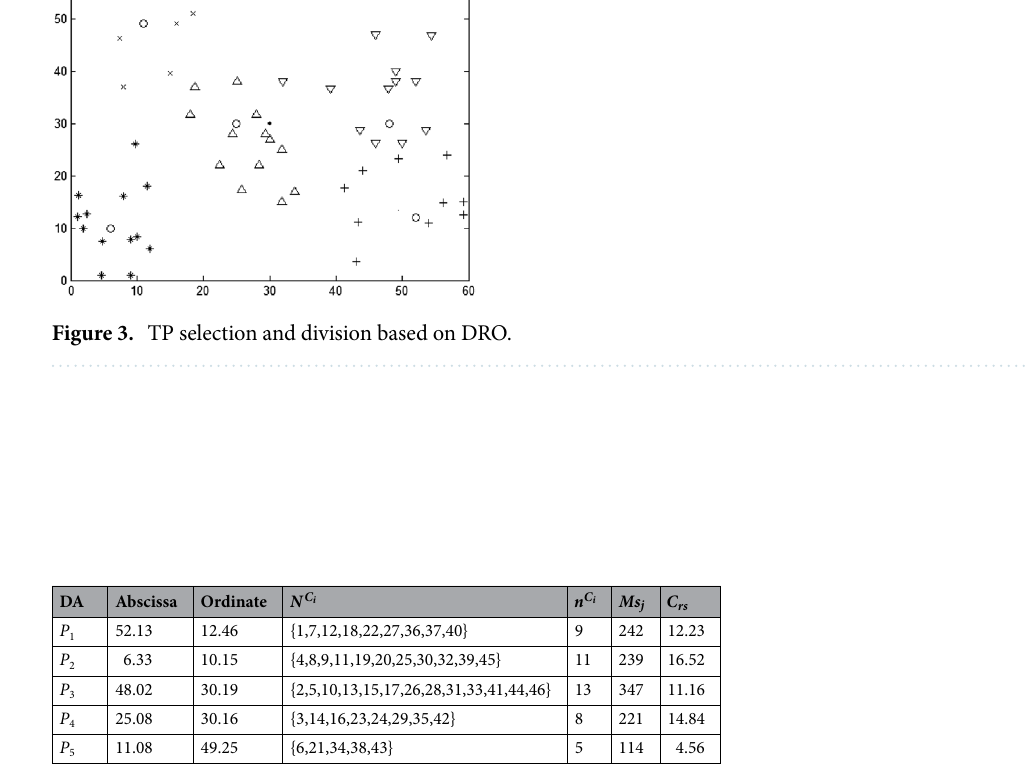
Table 2. Selection and division of TP based on